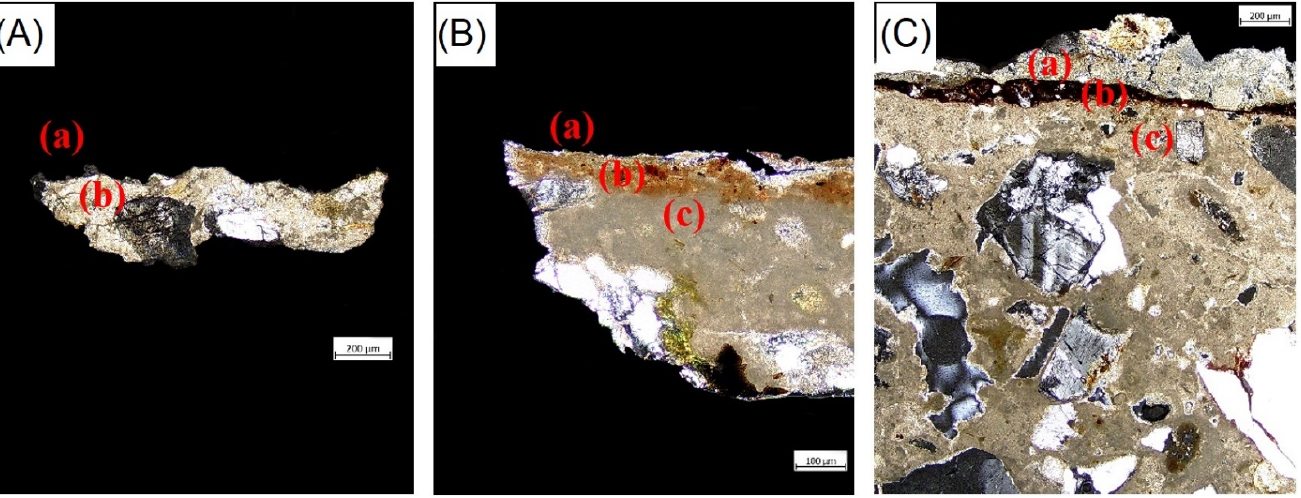
Figure 6. Photomicrographs by polarized light optical microscopy; Sample NST-3 (5×, CPL, scale- bar 200 µm) ( A ), Sample NST-4 (10×, CPL, scale-bar 100 µm) ( B ) and Sample NST-5 (5×, CPL, scale- µ m) ( A ), Sample NST-4 (10 × , CPL, scale-bar 100 µ m) ( B ) and Sample NST-5 (5 × , CPL, scale-bar bar 200 µm) ( C ). Note: CPL = Crossed Polarized Light. 200 200 µ m) ( C ). Note: CPL = Crossed Polarized